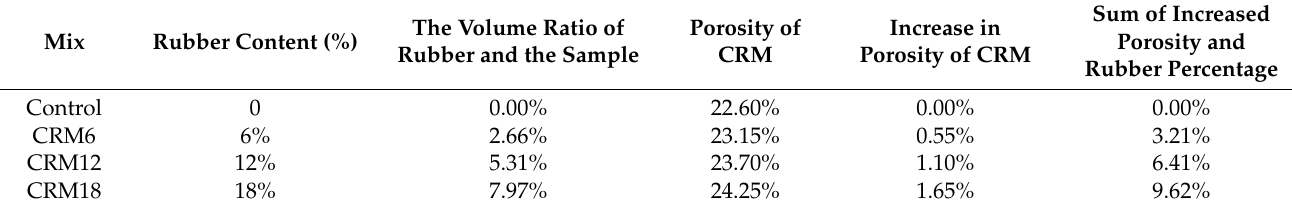
Table 9. Increased porosity of the CRM caused by the use of rubber particles.